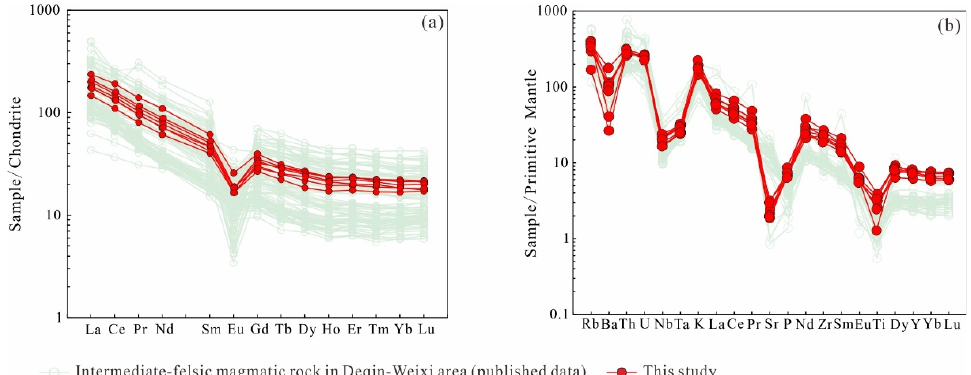
Figure 6. Geological discrimination plots for Deqin–Weixi intermediate-felsic magmatic rocks: ( a ) total alkali-silica (TAS) [39]; ( b ) Nb/Y-SiO 2 [40]; ( c ) SiO 2 -K 2 O [41]; ( d ) A/CNK-A/NK [42]. Data source: [8,10–12,15,43].